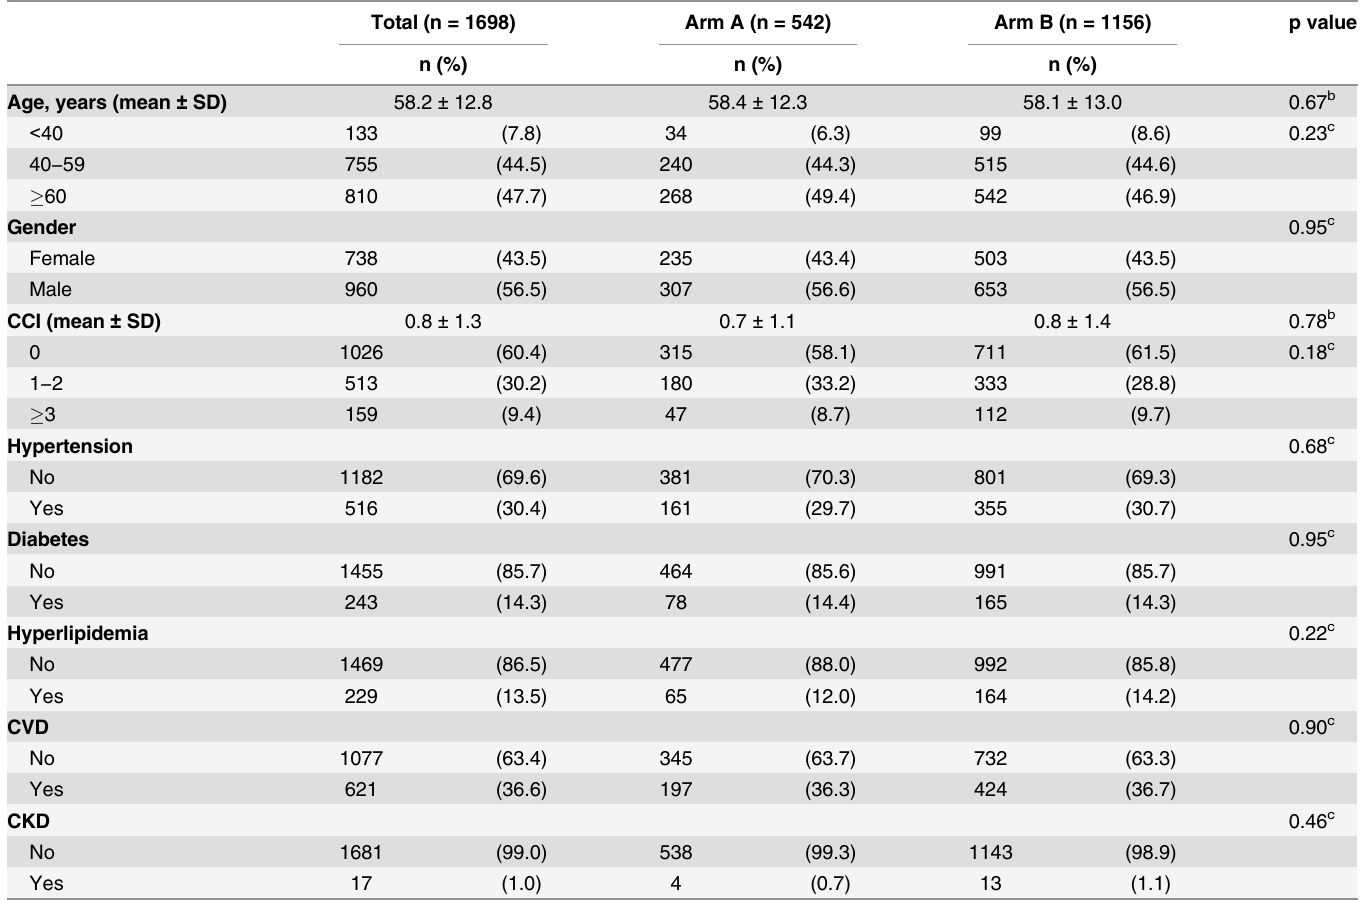
Table 2. Comparison of Clinical Characteristics of Patients in Arm A and Arm B a